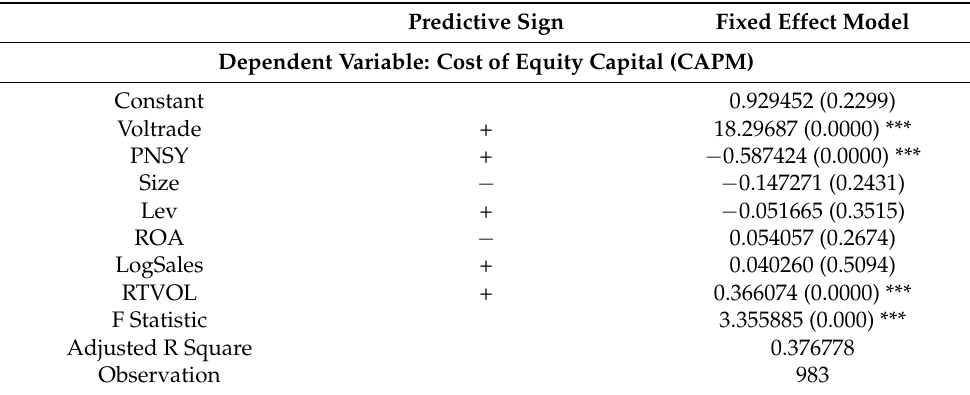
Table 4. Panel Data Testing with Fixed Effect